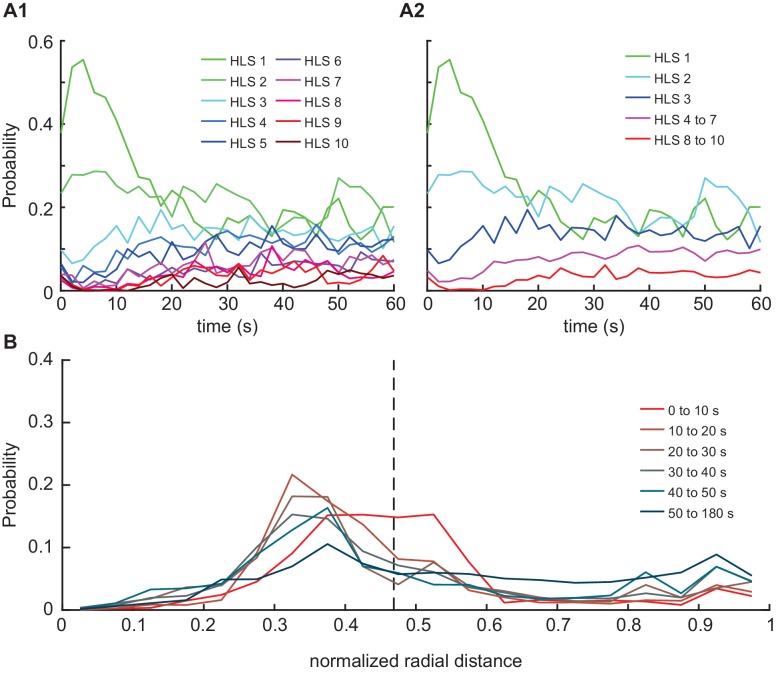
Temporal structure underlying HL state occupancy in response to odor.(A1) Probability of HL state occupancy following first entry inside the peripheral odor zone (radius = 1.9 cm). (A2) Medium speed walking states (4-7) were grouped and high-speed turning states (8-10) were grouped together, and the mean HL state occupancy were calculated for the respective groups. (B) The radial occupancy of the flies at different time groups following first entry. The black vertical dotted line indicates the nominal odor boundary (radius = 1.5 cm).